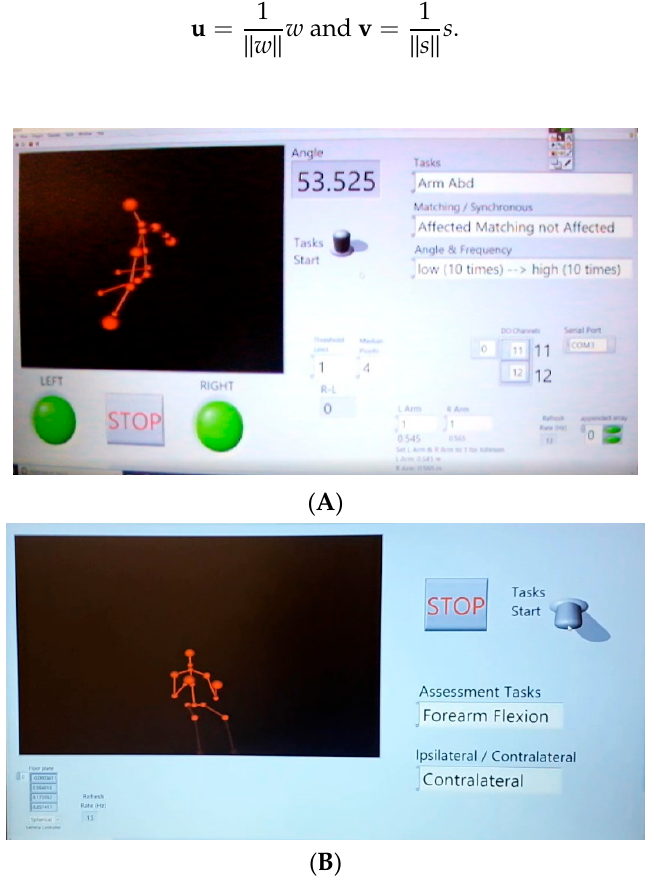
Figure 7. ( A ) LabVIEW training program; ( B ) LabVIEW assessment program.